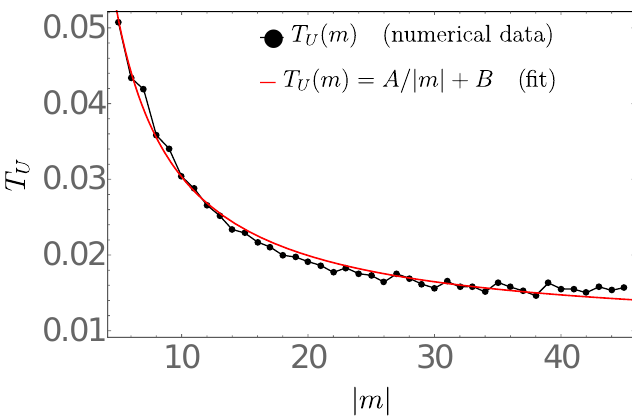
Figure 1: (color online) The Unruh temperature T in a finite lattice system for the U observer moving with a constant acceleration | a | = 1 / | m | . We consider here a square lattice on a cylinder (open boundary conditions along x ) of lengths 100 × 100, with the Rindler horizon laying on the circle along y at the half of the cylinder. The ( m ) where found from fitting a continuum limit curve (60) to numerical values T U the noninteracting numerical power spectrum for ω/ξ < 1. To the numerical results ( m ) = A / | m | + B and find A ≈ 0.2 and B ≈ 0.01. Thus, the behavior of T ( m ) we fit T U U ( m ) = 1 / ( 2 π | m | ) , in our finite lattice is remarkably close to the continuum result, T U predicted by the Bisognano-Wichmann